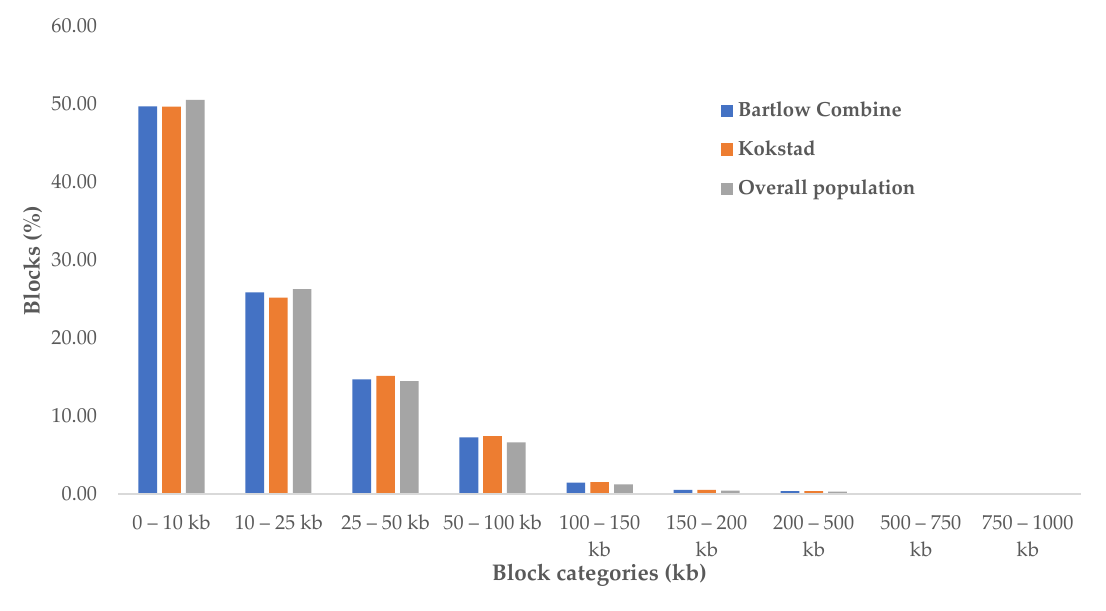
Figure 5. Proportion of haploblocks per block length category in Bartlow Combine, Kokstad, and overall Nguni cattle populations.